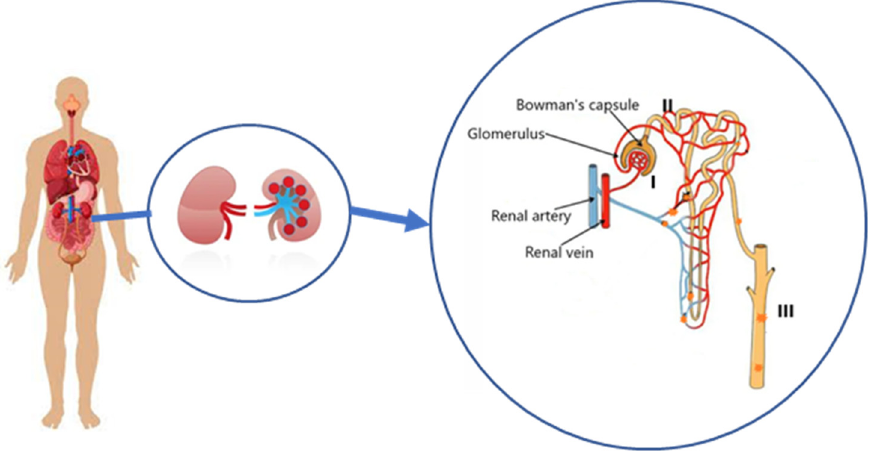
Figure 1. Description of the renal excretion of MPs: (I) through the bloodstream, MPs can flow inside of the glomerular tuft, without passing across the intact filtration barrier due to their size; (II) MPs are uptaken by the epithelial cells of the proximal convoluted tubules through endo- or macropinocytosis and then secreted into the tubular lumen; (III) MPs pass through the tubular system to be excreted with urine [39–42].